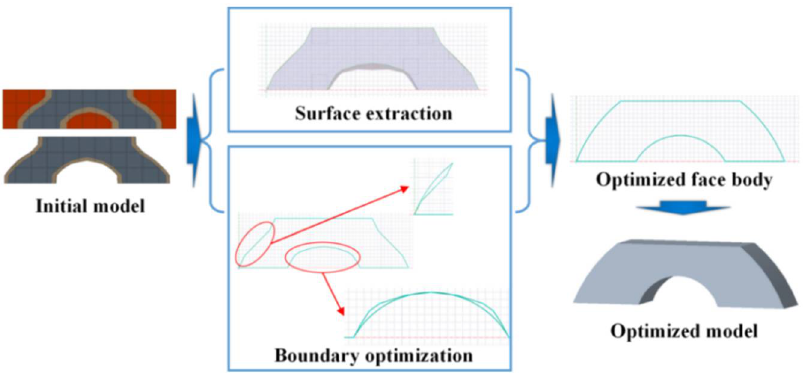
Figure 5. The schematic of the generation process of the topology-optimized model for further solid-body weight reduction under the load-bearing orientation and stress distribution. solid-body weight reduction under the load-bearing orientation and stress